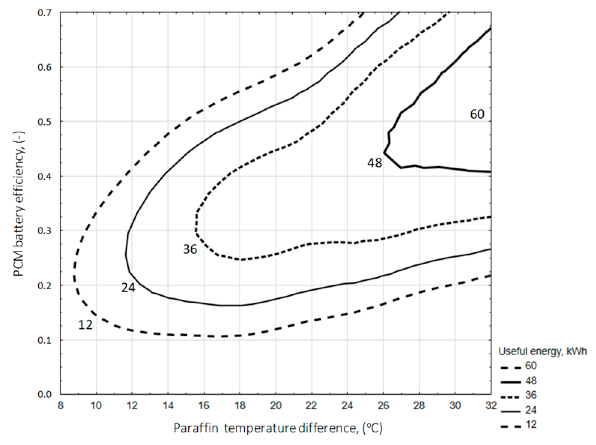
Figure 34. Useful energy in the heat storage process depending on the difference in paraffin temperature and heat storage efficiency.